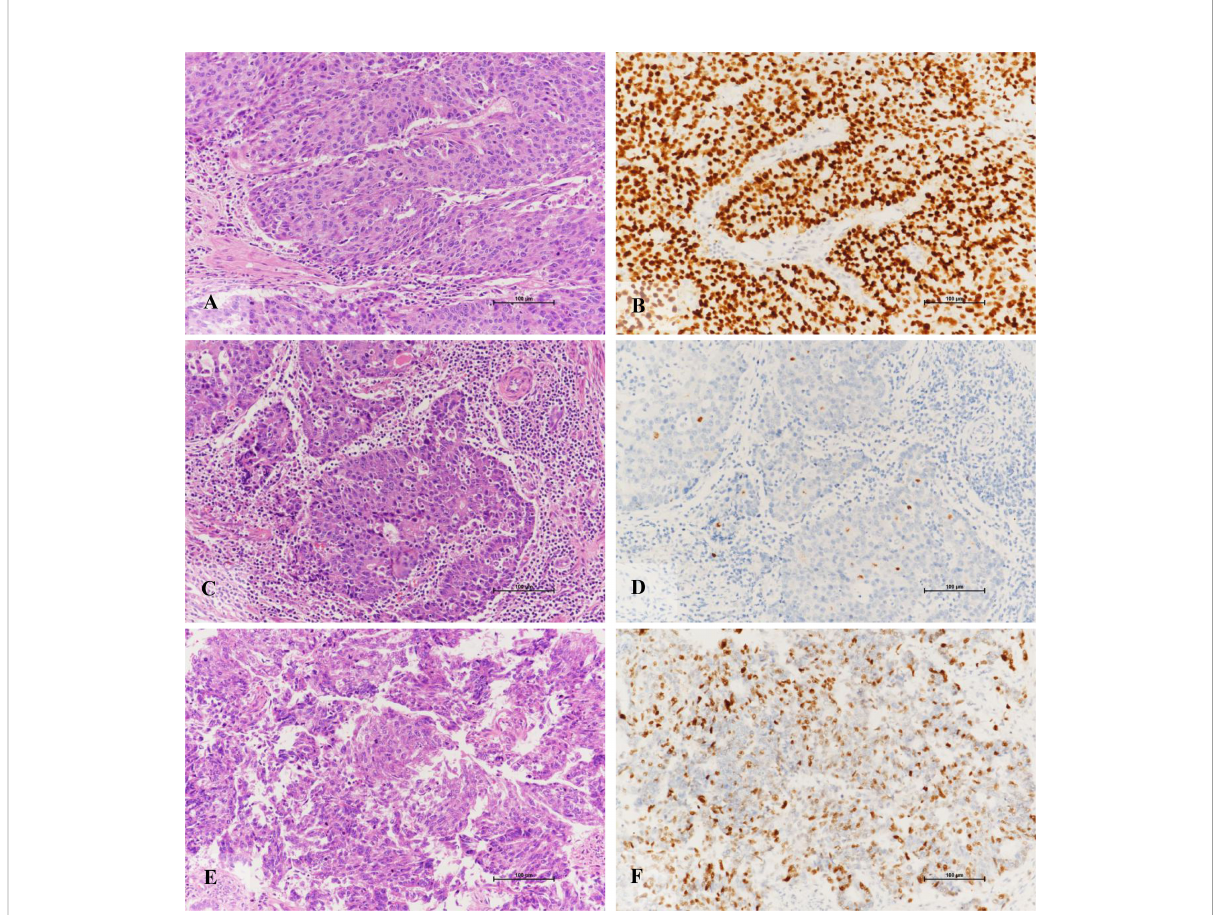
FIGURE 3 Immunohistochemical staining characteristics of EECs of TP53 subtypes. (A, B) Morphology of high-grade endometrioid adenocarcinoma with TP53 gene mutation and its diffuse positive expression pattern of p53 protein (X200). (C, D) High-grade endometrioid adenocarcinoma with TP53 gene mutation is rich in lymphocyte stroma and its p53 protein expression pattern is completely absent (X200). (E, F) The morphology of high-grade endometrioid adenocarcinoma without mutation of TP53 gene and its positive expression pattern of p53 protein